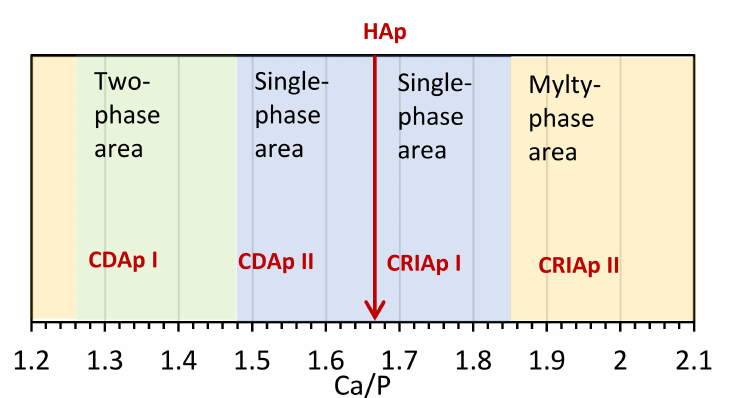
Figure 11. An outline of ranges of existence of the apatites produced by the mechanochemical method of